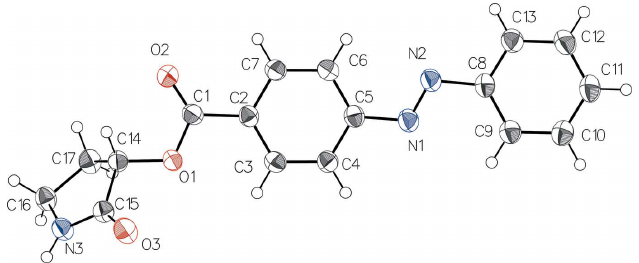
Figure 1 The molecular structure of the title compound, with displacement ellipsoids drawn at the 50% probability level. H atoms are shown as small spheres of arbitrary